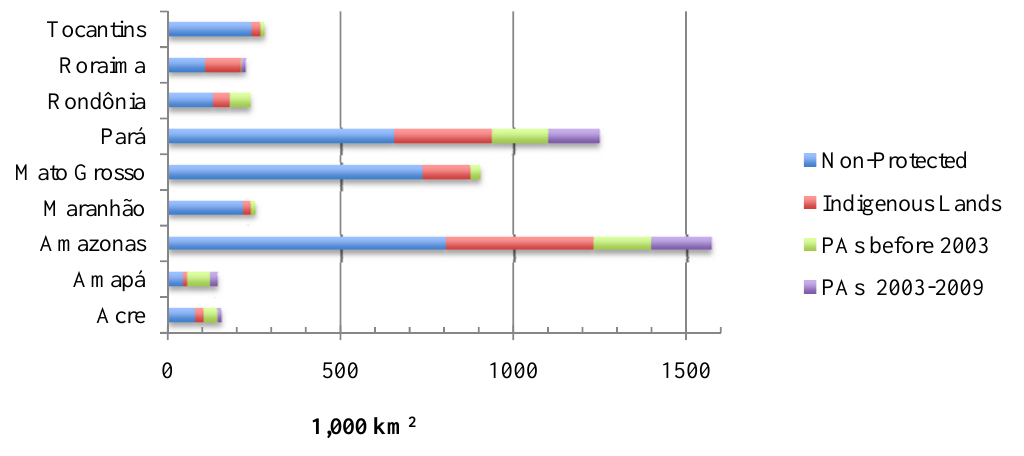
Figure 3. Area of protected and indigenous lands in Amazonian states (km 2